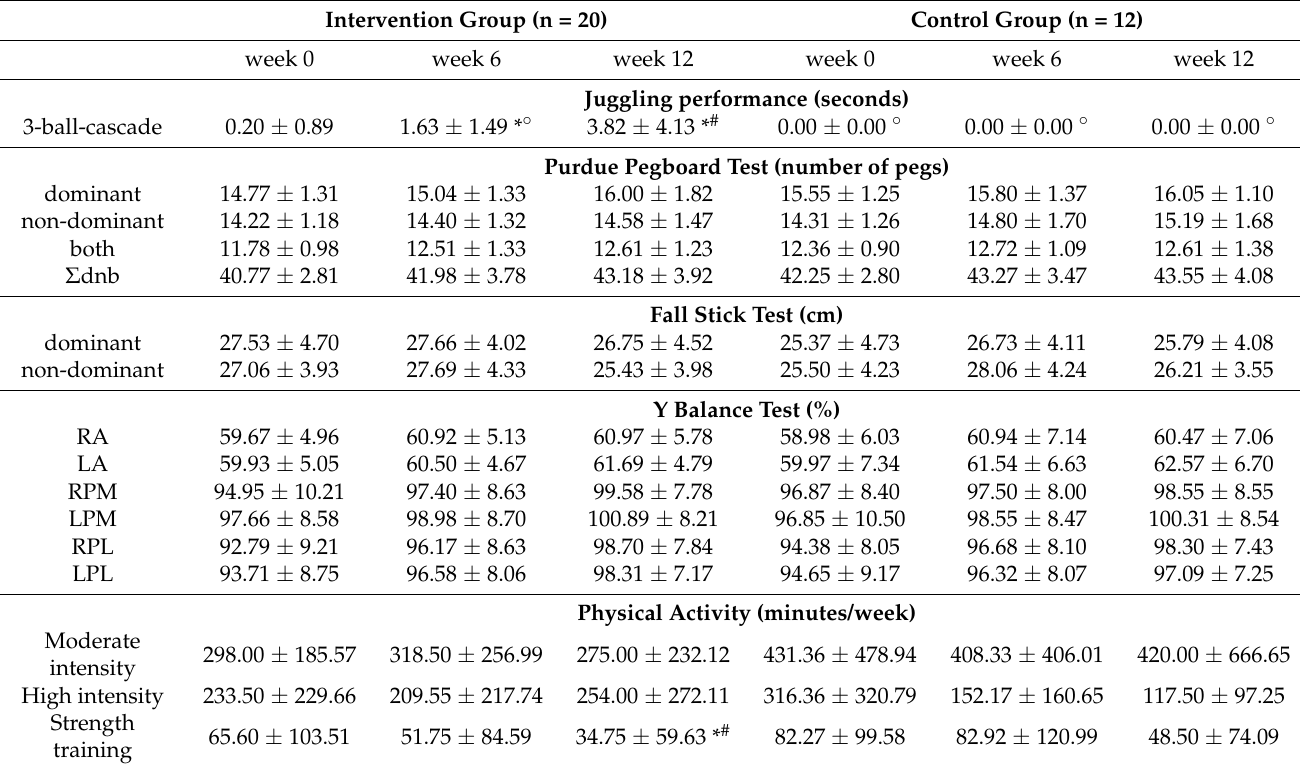
Table 3. Juggling performance, motor abilities, and physical activity of the participants of the intervention and control